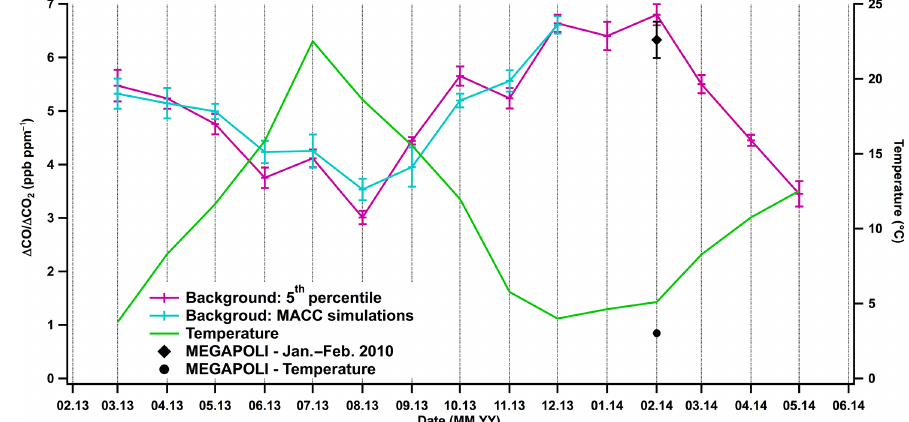
Figure 5. Monthly (cid:49) CO to (cid:49) CO 2 ratios in Paris. Results using background levels defined with the 5th percentile are given in violet. The ones using the MACC simulations are in blue. Error bars on the ratios correspond to 1 σ . The ratio from the MEGAPOLI/CO 2 -MegaParis campaign and the corresponding average temperature are represented by a black disk. Temperature corresponding to the selected data for the ratio calculation averaged by month is represented in green as a proxy for